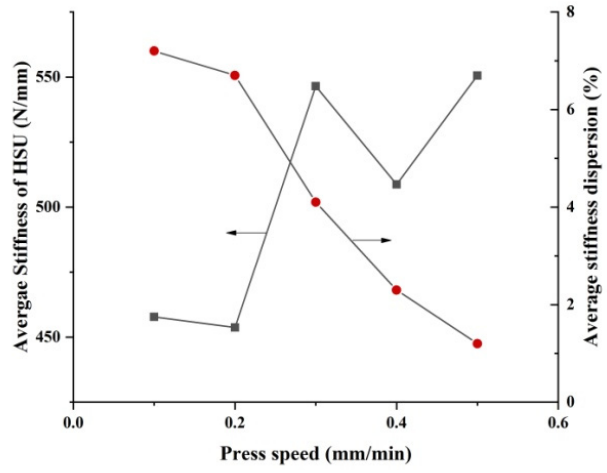
Figure 12. Average stiffness and stiffness dispersion of HSUs versus various press speeds.